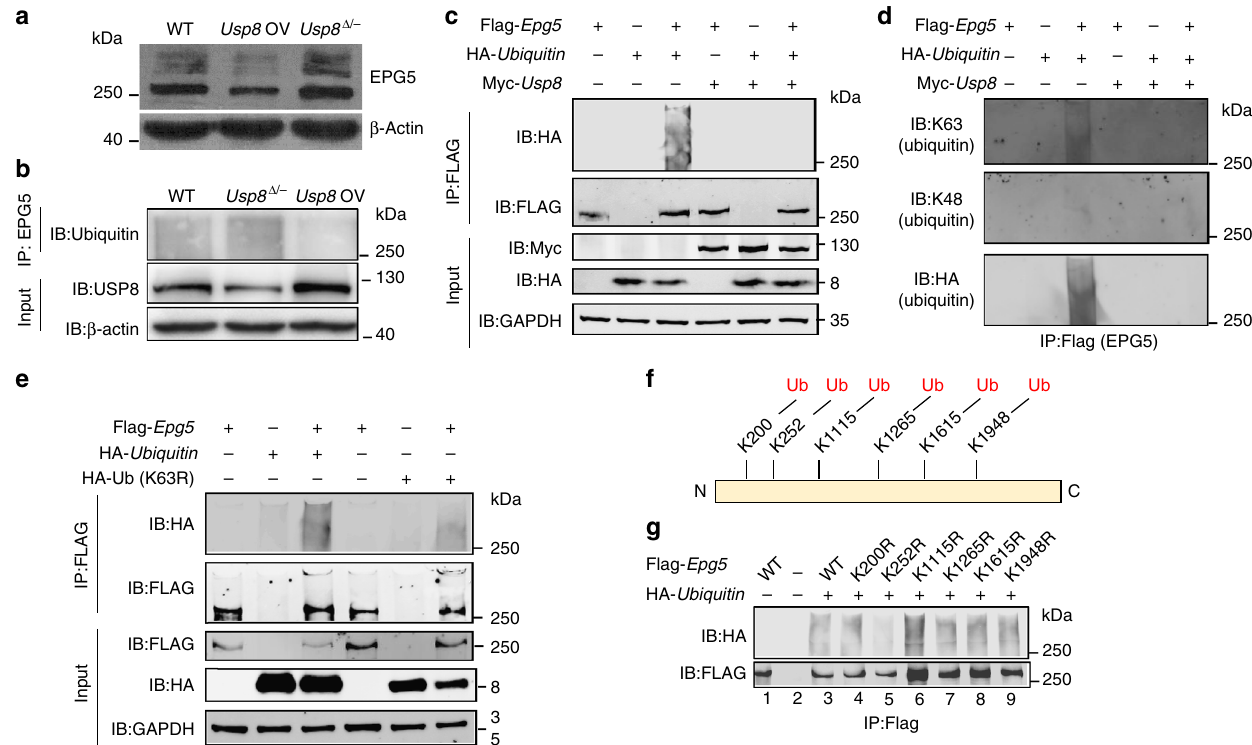
Fig. 5 USP8 deubiquitinates the EPG5. a Western blot analysis of whole-cell extracts from WT, Usp8 -overexpression and Usp8 ▵ / − ESC lines using anti-EPG5 antibody. β -Actin served as a loading control. Images are representative of three independent experiments. b Lysates from WT, Usp8 -overexpression and Usp8 ▵ / − ESC lines were immunoprecipitated with anti-EPG5 and immunoblotted with anti-ubiquitin. Input cell lysates were immunoblotted with anti-USP8 and β -actin as controls. c Lysates of HEK293T cells transfected with plasmids encoding Flag- Epg5 , HA- Ubiquitin and Myc- Usp8 were immunoprecipitated with anti-Flag and immunoblotted with anti-HA and anti-FLAG. Input cell lysates were immunoblotted with anti-Myc, anti-HA, and anti-GAPDH as controls. d Lysates of HEK293T cells transfected with plasmids encoding Flag- Epg5 , HA- Ubiquitin , and Myc- Usp8 were immunoprecipitated with anti-Flag and immunoblotted with anti-K63, anti-K48, and anti-HA antibodies. e Lysates of HEK293T cells transfected with plasmids encoding Flag- Epg5 , HA- Ubiquitin , or HA- Ubiquitin (K63R) were immunoprecipitated with anti-Flag and immunoblotted with anti-HA and anti-FLAG antibodies. Input cell lysates were immunoblotted with anti-FLAG, anti-HA and anti-GAPDH antibodies as controls. f Proteins from ESCs expressing Flag- Epg5 were analyzed by LC-MS/MS mass spectrometry. Ubiquitination sites identi fi ed on EPG5 are indicated. g )Immunoblot analysis of protein extracts of HEK293T cells transfected with HA- Ubiquitin together with plasmids expressing WT Flag- Epg5 or K200R, K252R, K1115R, K1265R, K1615R, and K1948R mutants of Flag-